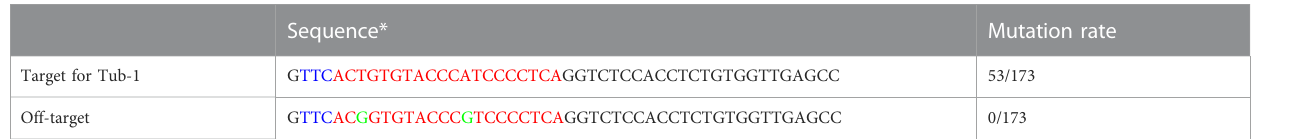
TABLE 2 Off-target sequence of